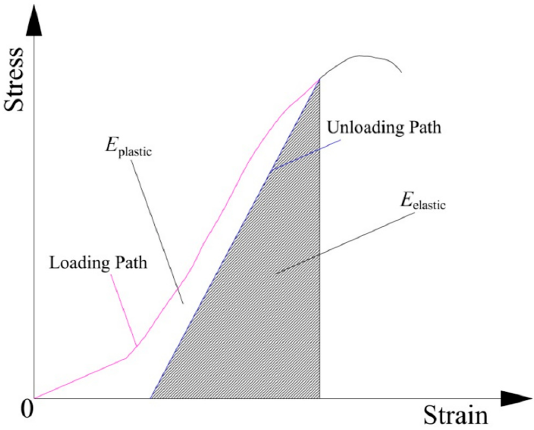
Figure 1. Schematic diagram of the elastic and plastic energies of coal subjected to a compression load.